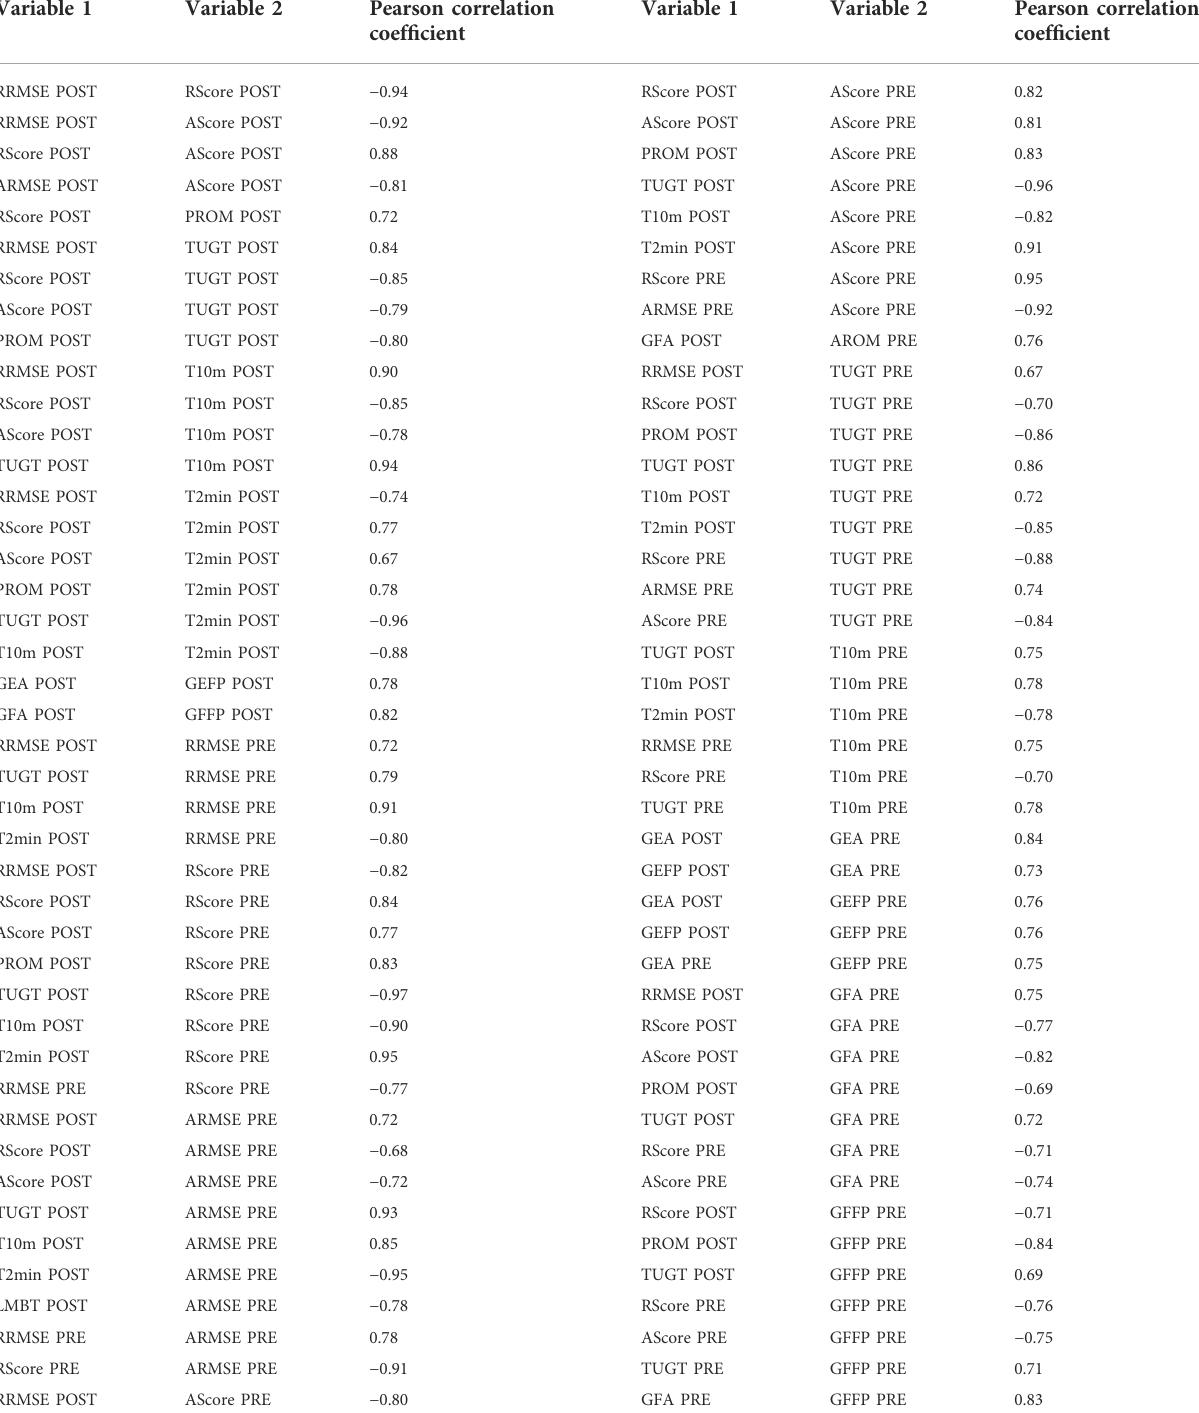
TABLE 9 Pearson correlations table ( p > 0.05) for PRE and POST – treatment